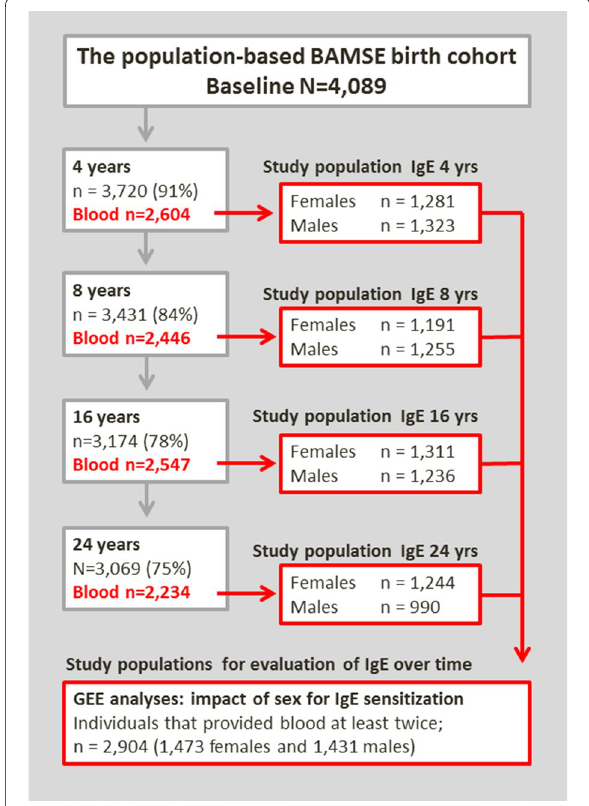
Fig. 1 Flow chart of the current study and study-populations used for included